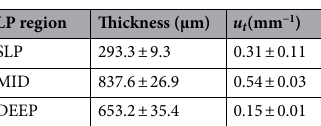
Table 2. Quantitative morphometric evaluation of the human vocal fold lamina propria using